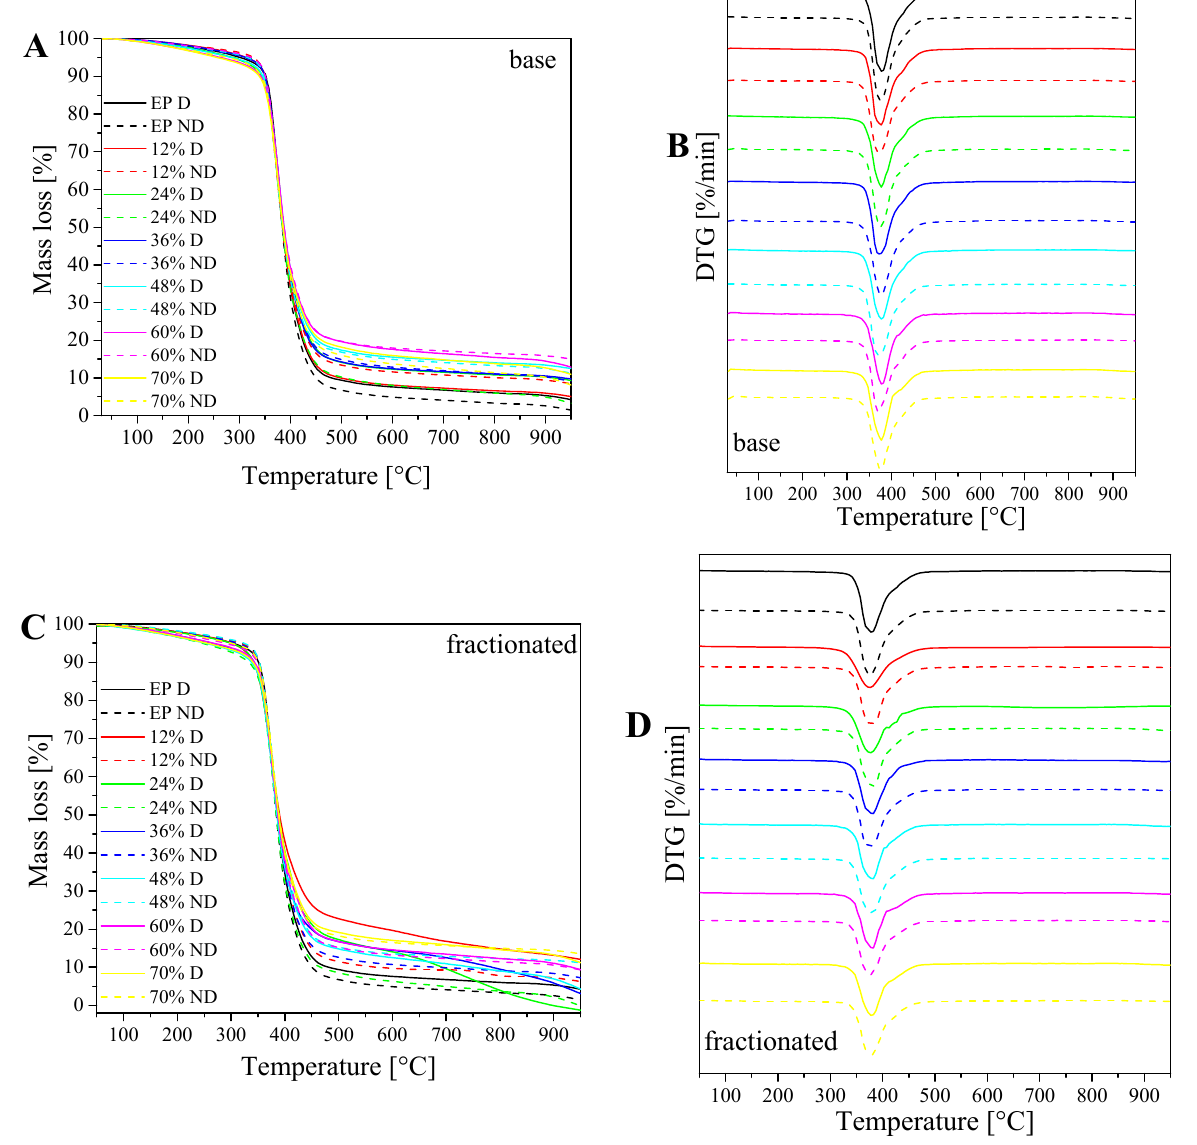
Figure 18. Changes in weight (TG) and the rate of changes with increasing temperature (DTG) curves for degassed and non-degassed composites containing base diatoms ( A , B ) and fractionated diatoms ( C , D ).